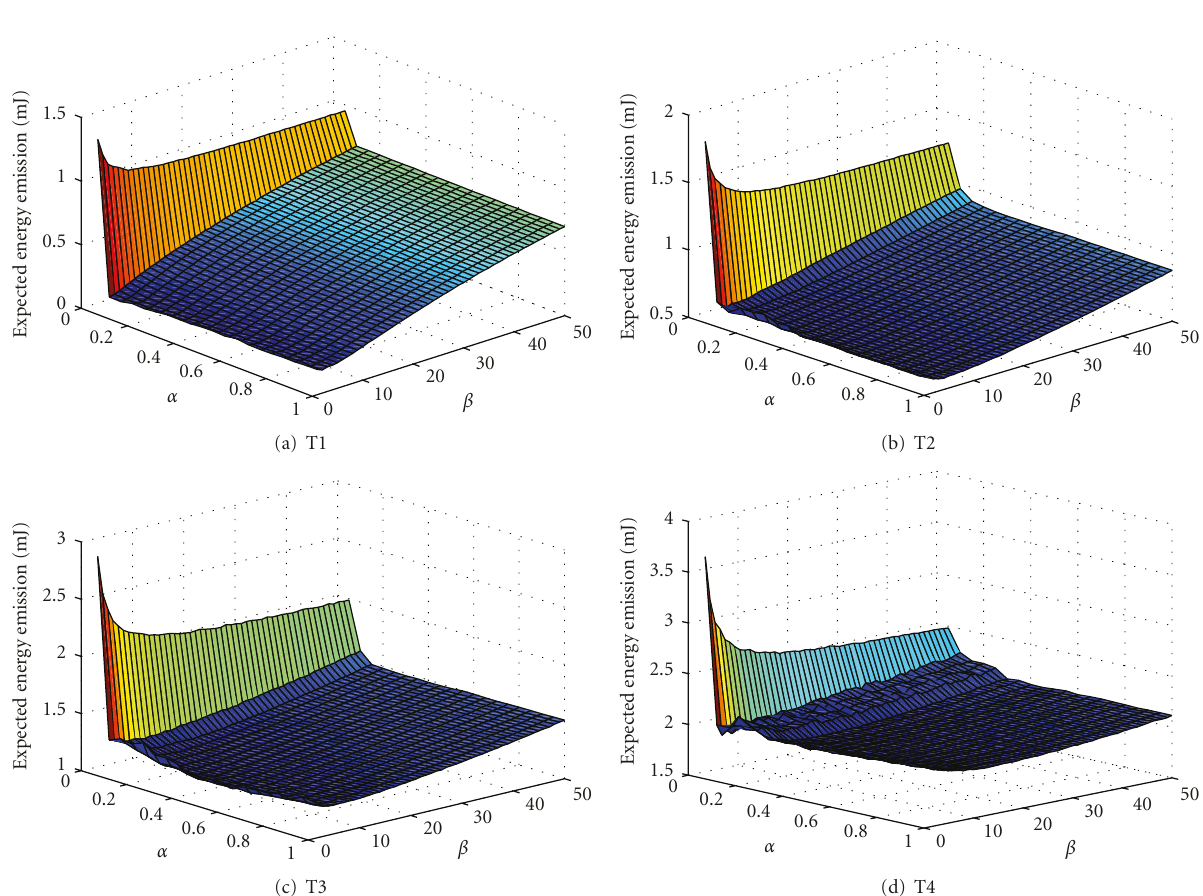
Figure 8: 3D α and β combinations for di ff erent Scenarios